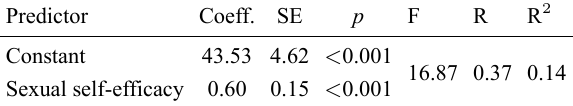
Table 2. The result of regression